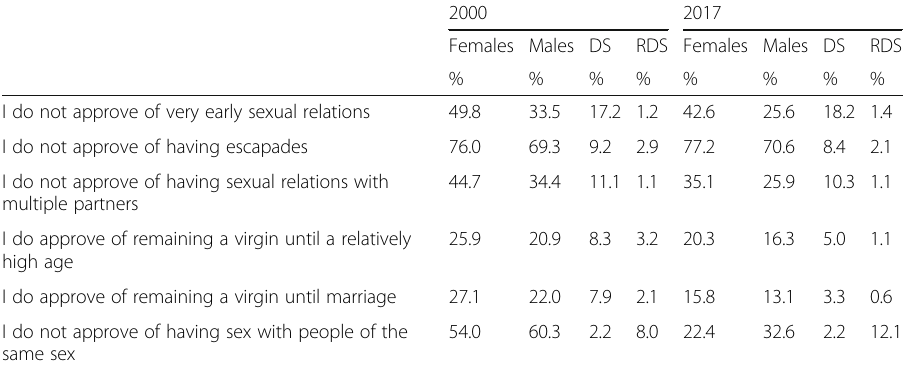
Table 1 (Dis)approval of certain sexual behaviours (by both males and females), double standard (DS) and reverse double standard